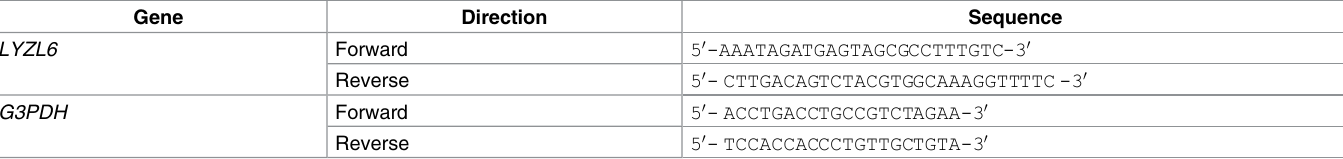
Table 1. Gene specific primers used in this study.